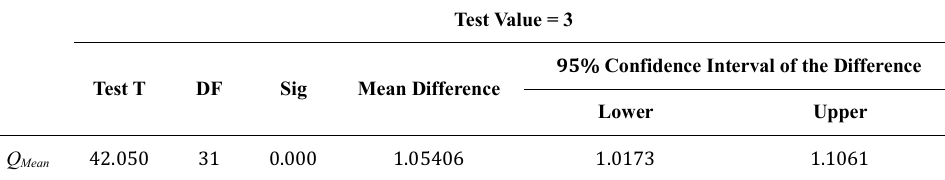
Table 6. One-Sample Test